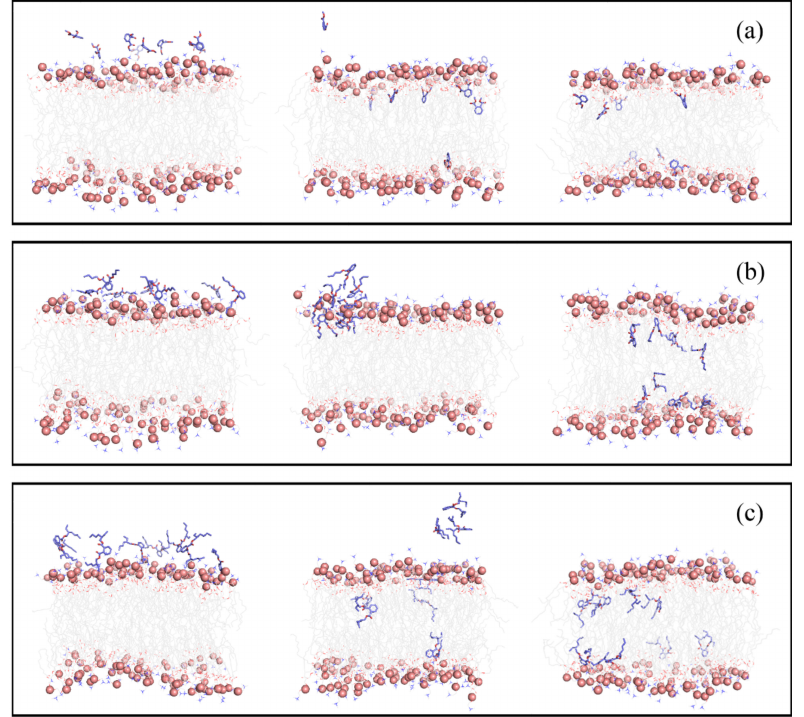
Figure 2. Side view of representative snapshots for the penetration pathway of systems with DMP ( a ), DBP ( b ), and DEHP ( c ),